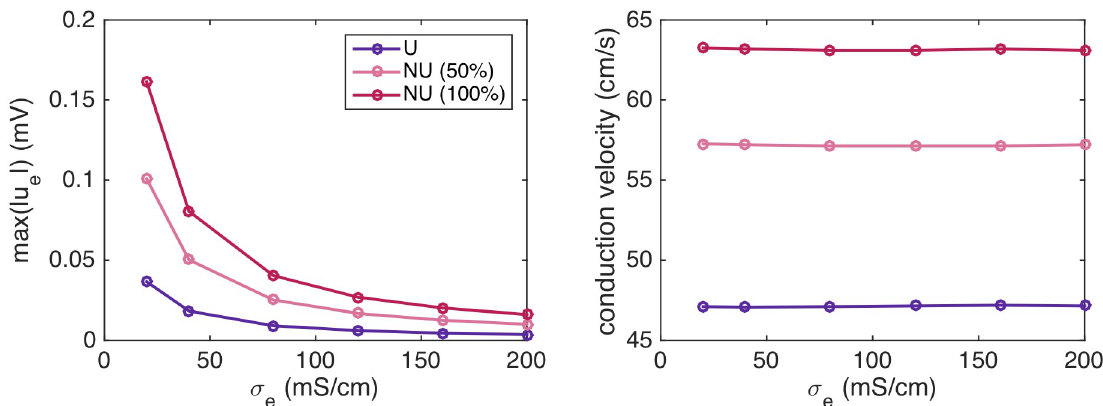
Fig 17. The conduction velocity for a cell distance of 4 μ m is nearly constant as the magnitude of the extracellular potential decreases. The left panel shows the maximum absolute value of the extracellular potential as the value of σ setup as in Fig 4, with 0% (U), 50% and 100% of the sodium channels moved to the cell ends. The right panel shows the conduction velocity computed in each of the